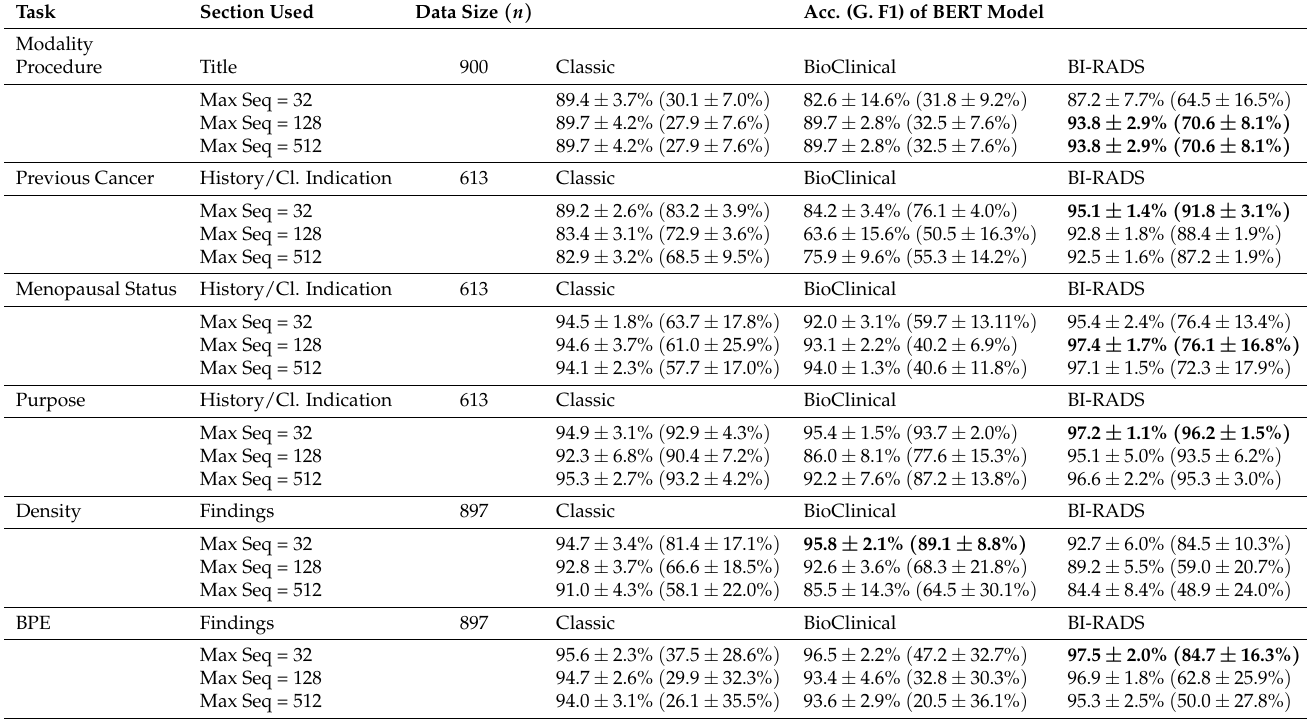
Table A1. Results of field extraction with section